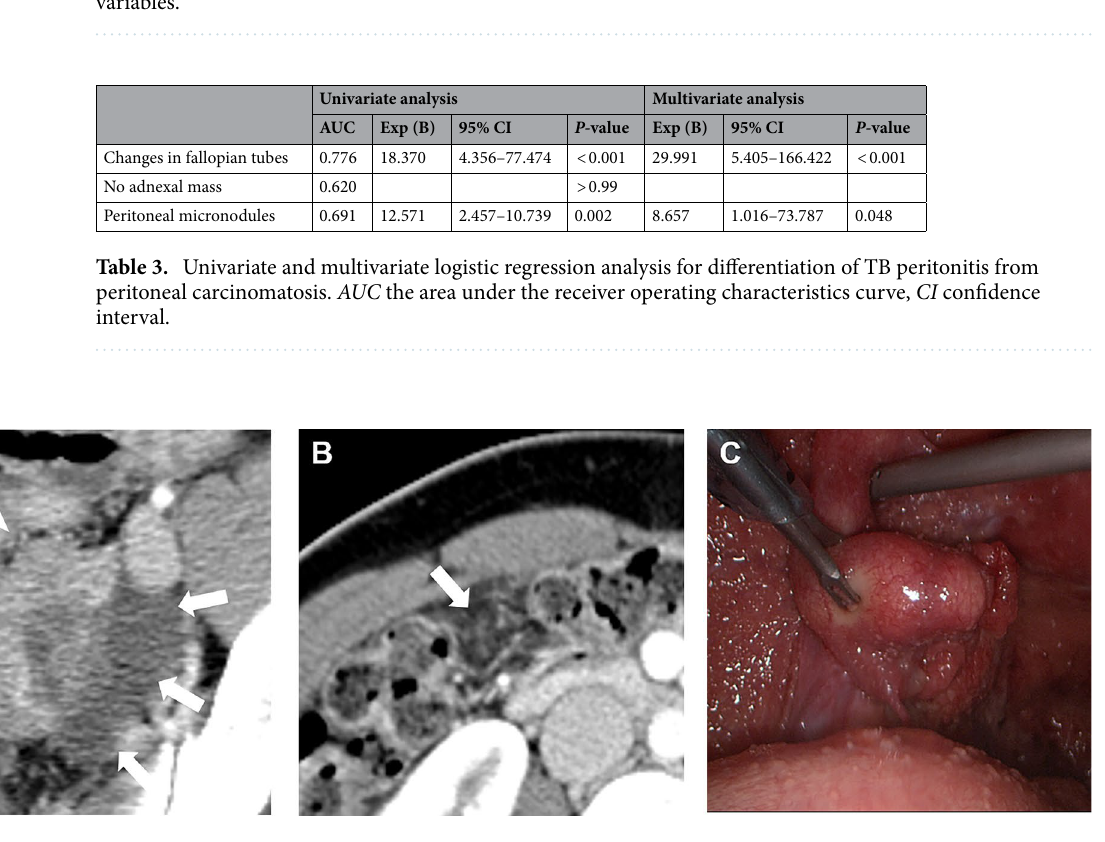
Table 2. Discriminant CT imaging features between TB peritonitis and peritoneal carcinomatosis. Data are the number of patients (percentage). HU Hounsfield unit. *Data are presented as the median (range) of the variables.